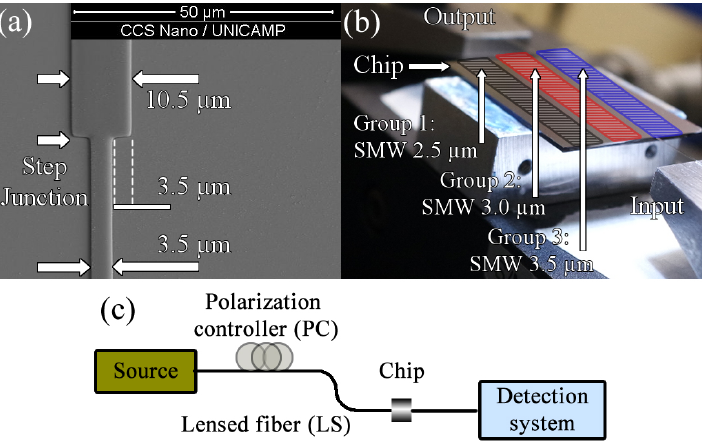
Figure 3. Fabrication and characterization system of the trimodal interferometer device. ( a ) The SEM image of a trimodal device, highlighting the single- and multimode area and the step junction section, respectively. ( b ) The experimental setup for the trimodal interferometers. ( c ) Design of the experimental setup to characterize the manufactured interferometric